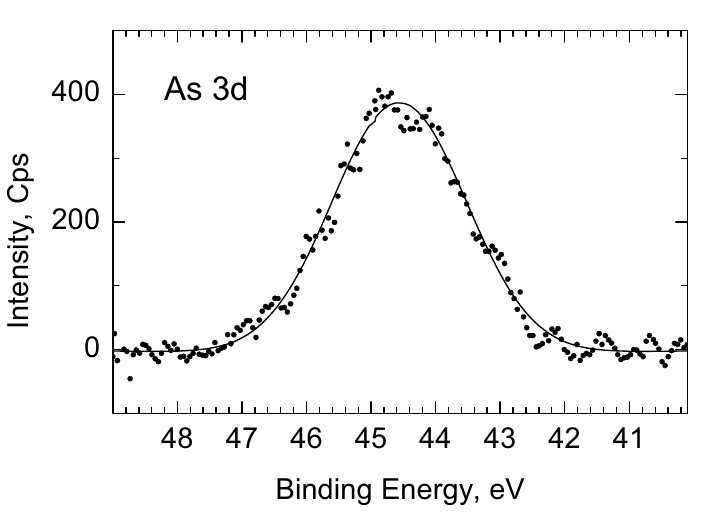
Fig. 5 XPS As 2p spectra of ODA-clinoptilolite with adsorbed arsenate.